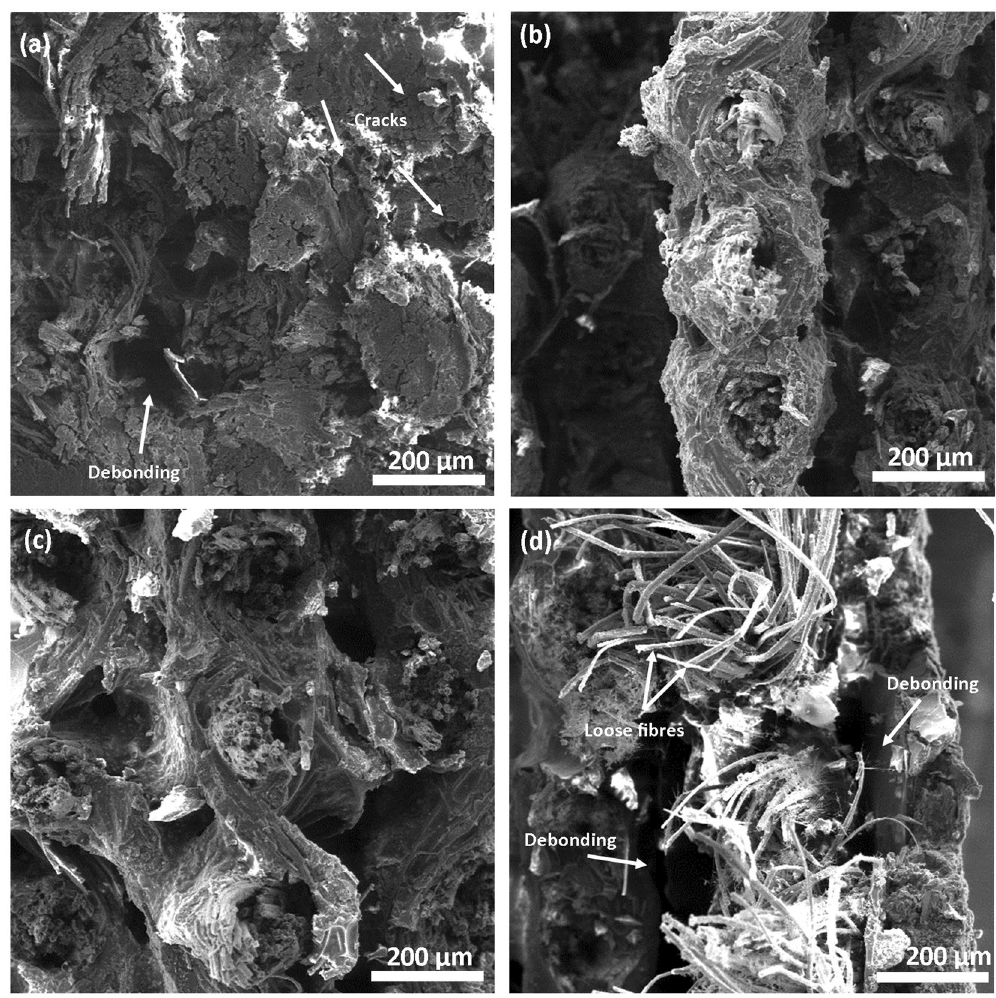
Figure 6. SEM images of flax/phenolic laminates ( a ) uncoated, ( b ) PU, ( c ) PFA and ( d )